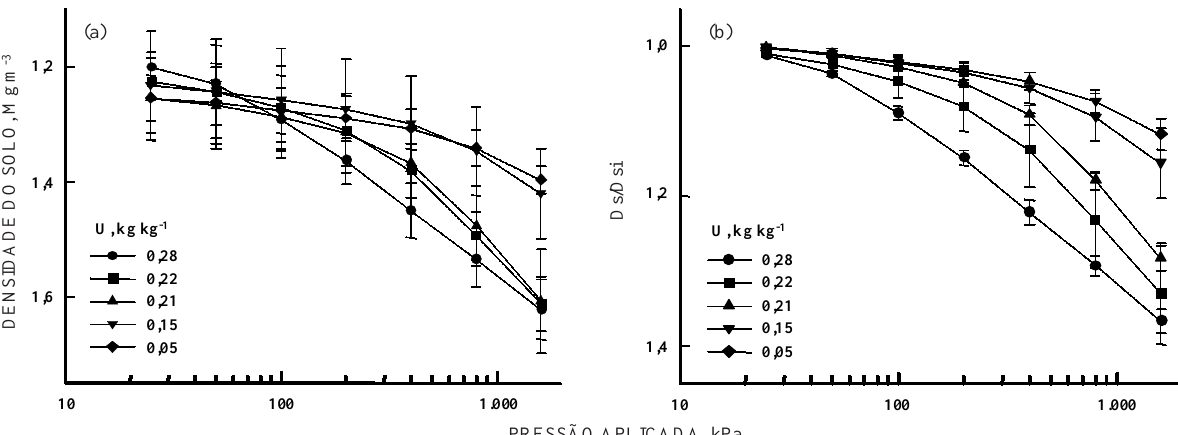
Figura 2. Curvas de compressão (a) e curvas de compressão normalizadas (b) para o Latossolo Vermelho- Amarelo sob mata natural, na profundidade de 0,27-0,30 m, médias de três repetições (as barras de erro representam o desvio-padrão da